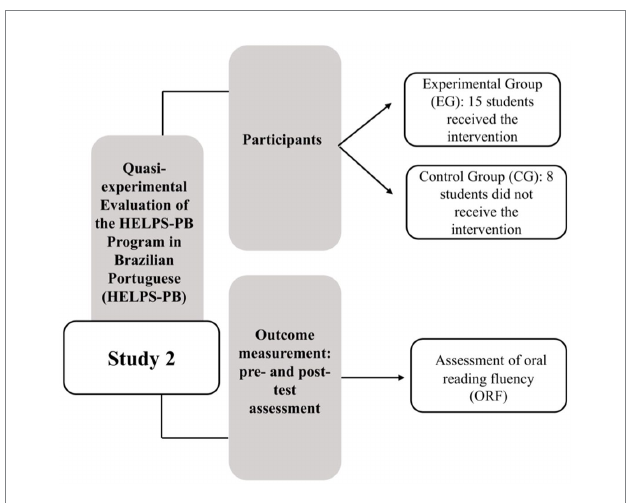
FIGURE 2 Diagram for the primary stages and activities of Study